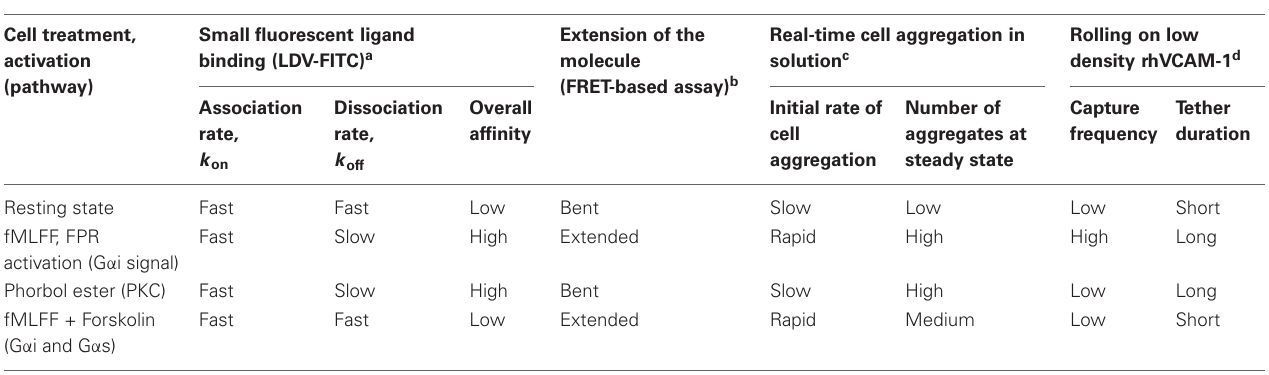
Table 2 | Behavior of VLA-4 conformational states using several approaches. Cell